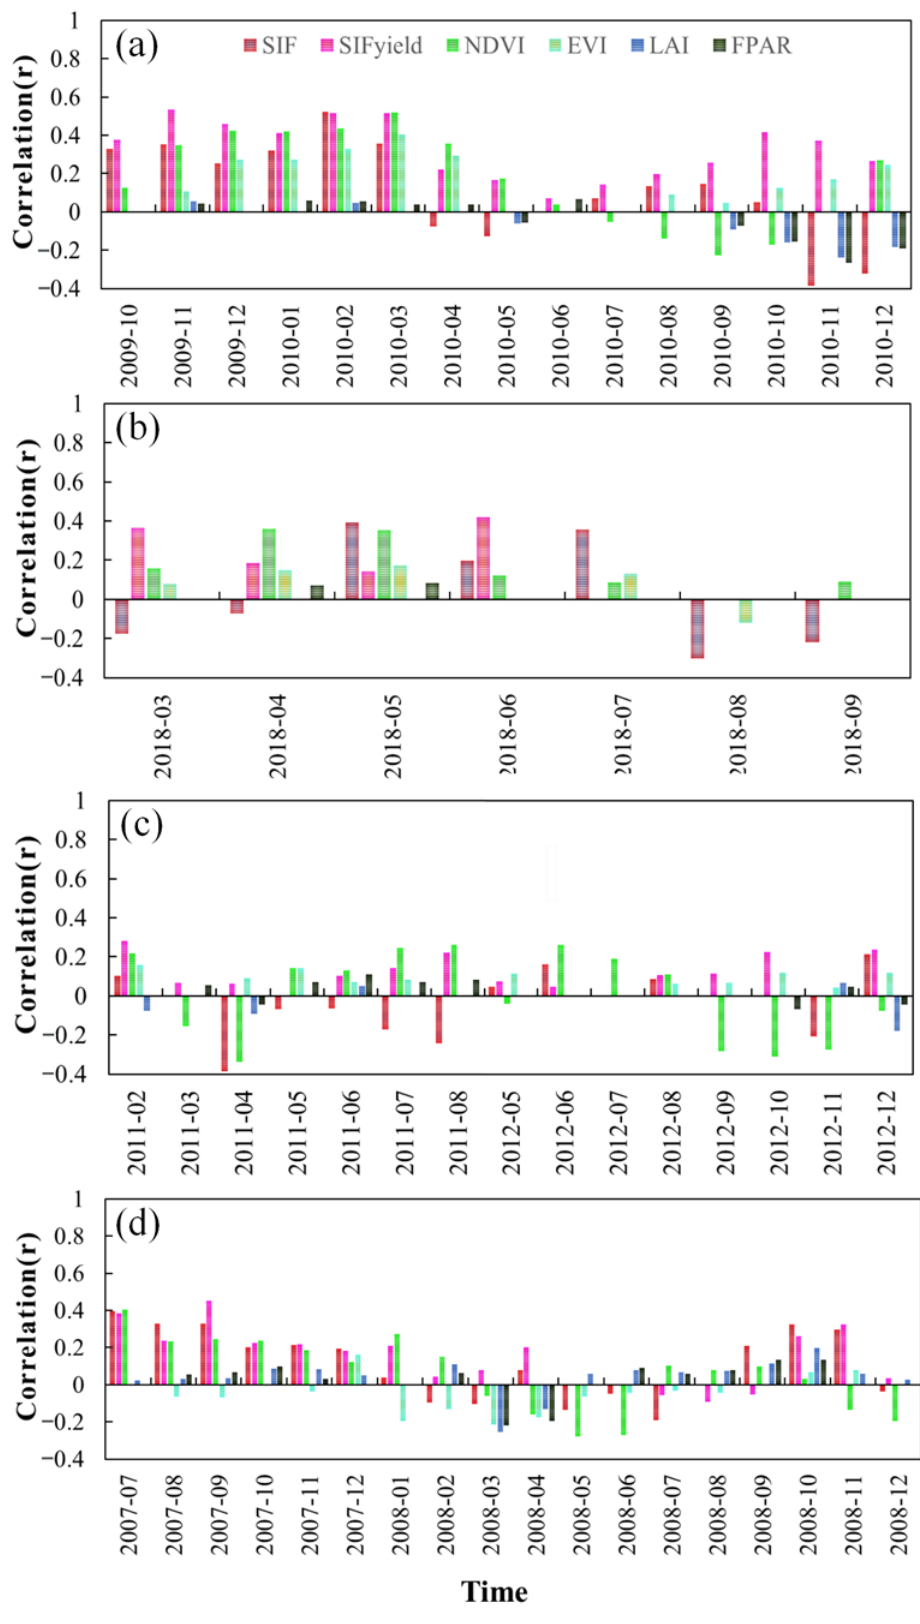
Figure 8. Correlation between standardized anomalies of SIF, SIFyield, NDVI, EVI, LAI, and fPAR with SPEI. ( a ) Yunnan province; ( b ) Fujian province; ( c ) Shaanxi province; and ( d ) Heilongjiang